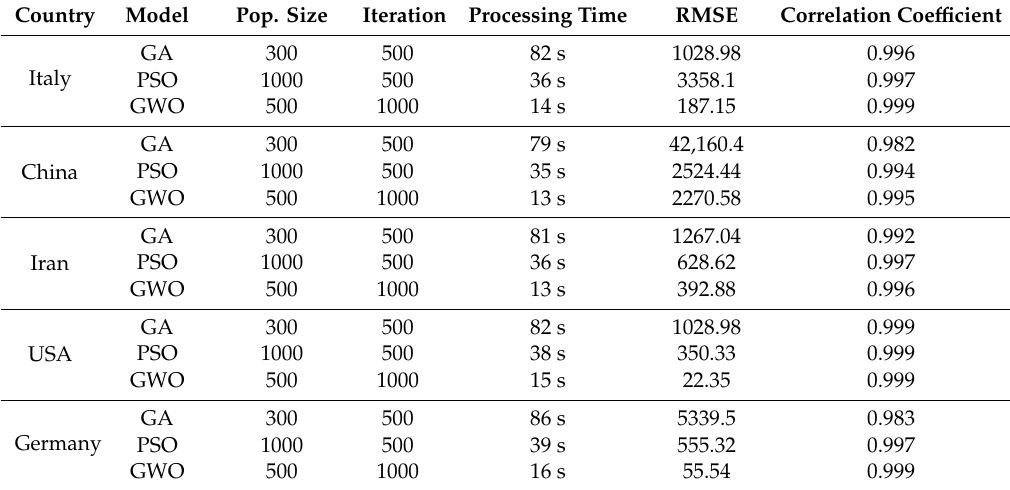
Table 3. Accuracy statistics for the logistic model.